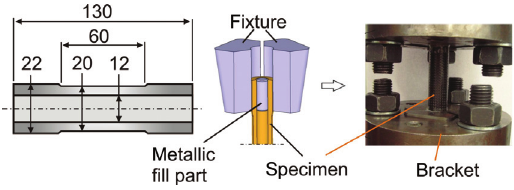
Figure 15 Torque specimen geometry (left) and testing setup (right).